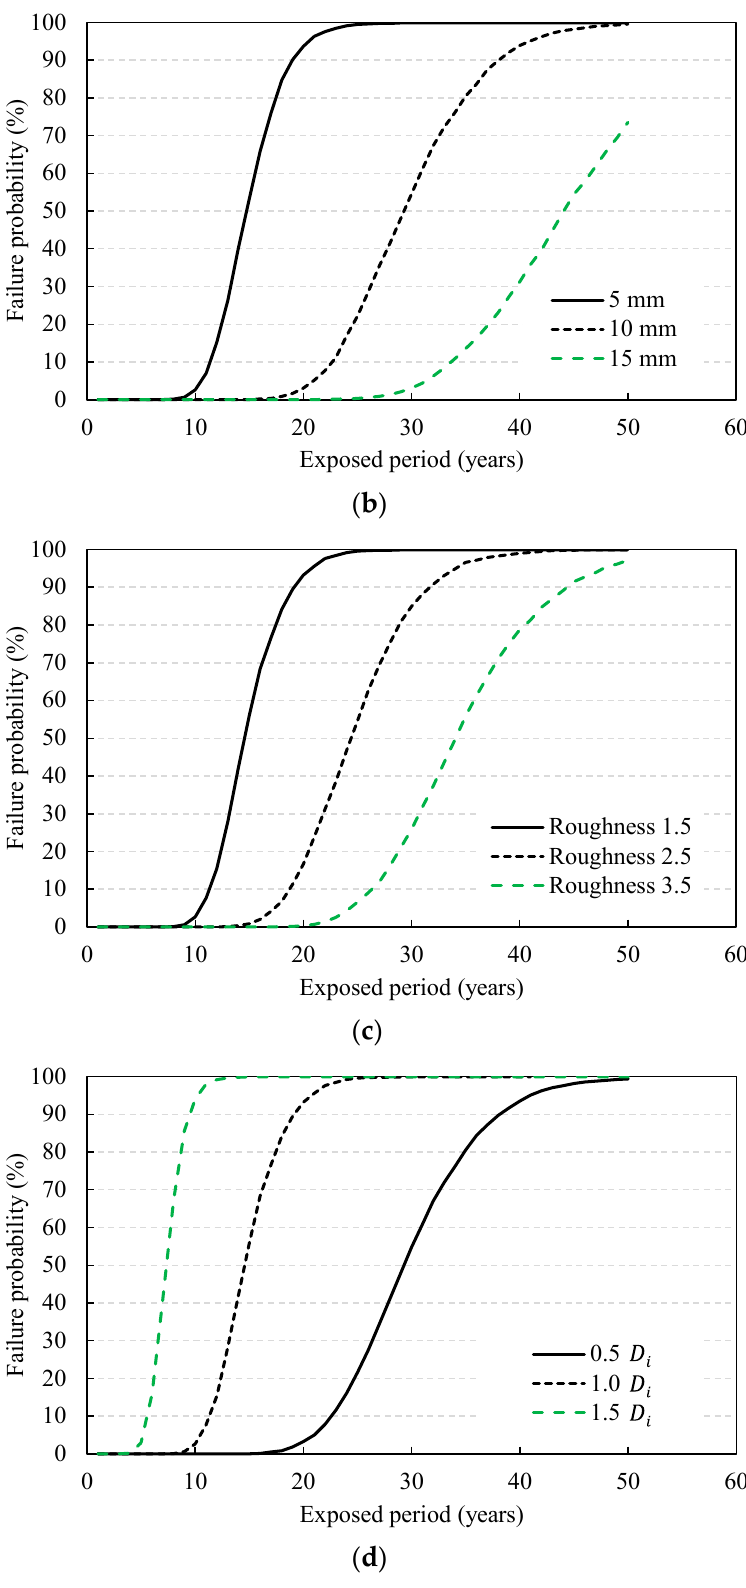
Figure 9. Changes in failure probability with design variables: ( a ) exterior sulfate ions; ( b ) coating thickness; ( c ) surface roughness; ( d ) diffusion coefficient.